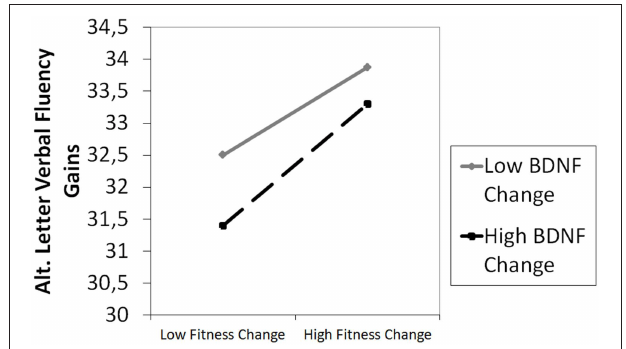
FIGURE 5 | Moderation of the effect of change in overall physical fitness on gains in alternating (alt.) letter verbal fluency by change in BDNF ( β = 0.37 , p = 0.04 ). High changes in overall fitness were predictive for high cognitive gains ( β = 0.31, p = 0.07 ). This positive association was moderated by the BDNF change and strengthened with higher change scores in BDNF. However, participants with lower BDNF change scores showed higher gains in alternating letter verbal fluency than those with higher change